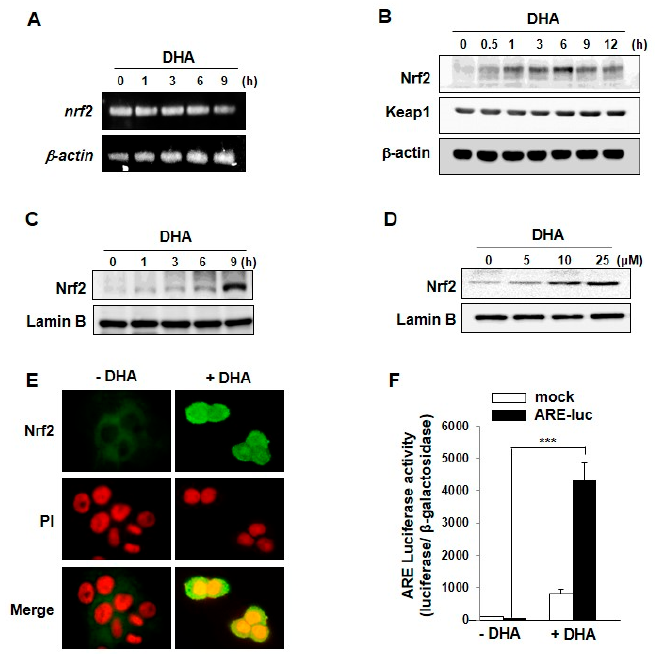
Figure 2. DHA-induced expression, nuclear translocation and transcriptional activity of Nrf2. ( A ) Total RNA was isolated from cells treated with or without DHA for indicated duration and analyzed by RT-PCR for detecting the level of Nrf2 mRNA. ( B ) MCF-10Acells were exposed to DHA (25 μ M) were harvested at the indicated intervals, and the protein levels were assessed by Western blot analysis. ( C ) Nuclear extracts from MCF-10A cells were prepared at the indicated intervals after treatment with DHA (25 μ M); ( D ) MCF-10A cells were treated with indicated concentrations of DHA for 9 h and the nuclear translocation of Nrf2 was assessed by Western blot analysis; ( E ) MCF-10A cells were incubated with DHA (25 μ M) for 9 h and nuclear localization of Nrf2 was determined by immunocytochemical analysis; ( F ) MCF-10A cells were treated with DHA (25 μ M) for 9 h after transfection with either an ARE luciferase construct or a control vector and analyzed for the Nrf2 transcriptional activity as described in Materials and Methods. Columns, means (n = 3); bars, SD. ***, p < 0.001.